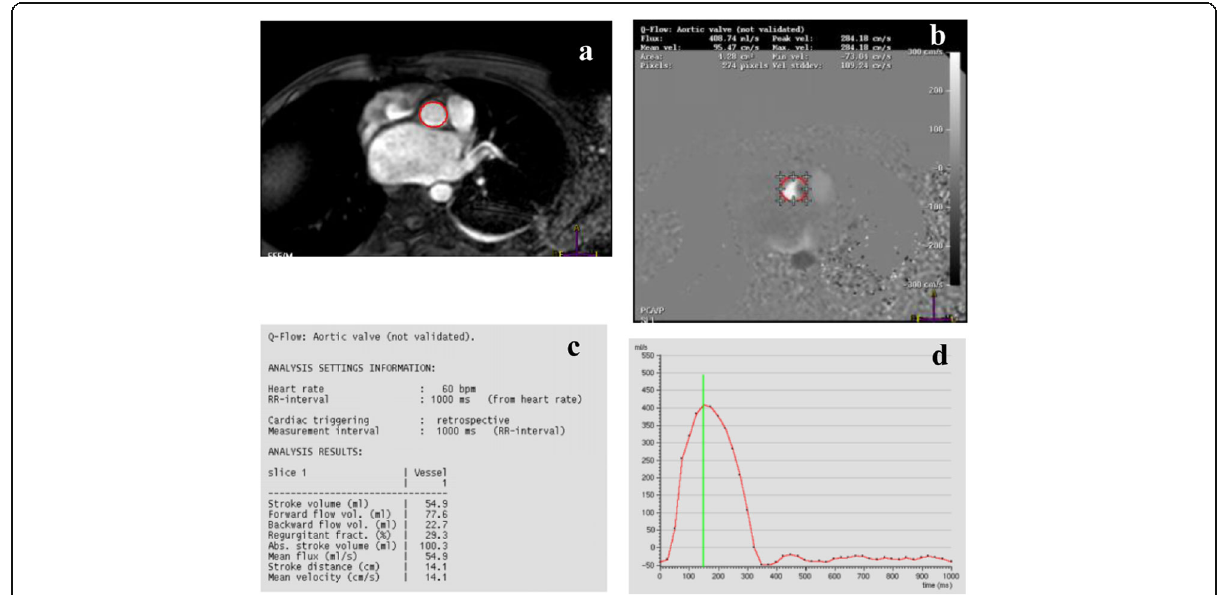
Fig. 7 On the other hand, the same patient using the phase-contrast analysis, the LV stroke volume (SVPC) was 54.9 ml and the ejection fraction (EFPC) was (54.9/221.1) × 100 = 24.8% (severe dysfunction). a The magnitute image showing the detailed anatomy, contour, and the shape of the aorta. b The phase velocity map depicts the velocity and direction of flow in each pixel within the aortic valve during systole. c Q-flow analysis of the aortic flow. d By outlining the contours of the aorta throughout each phase in the cardiac cycle, a flow curve can be generated to determine aortic forward reverse stroke volume and flow